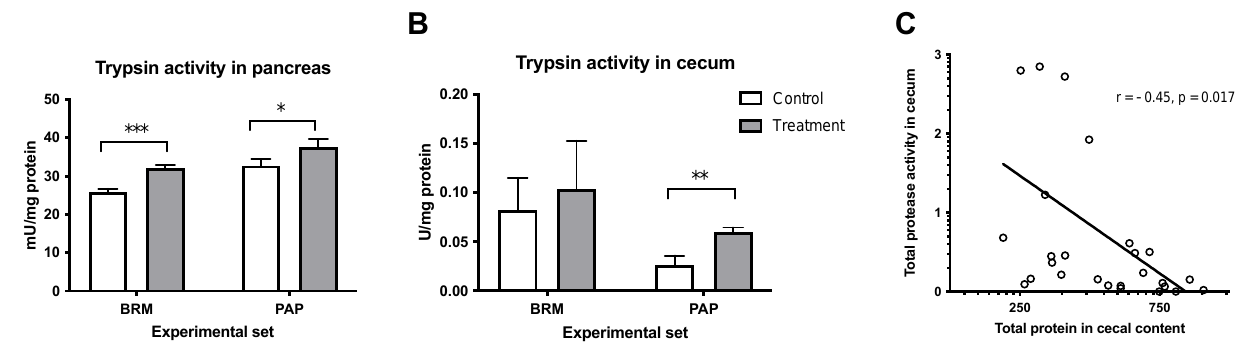
Figure 4. Effect of bromelain and papain on the activity of trypsin in the pancreas ( A ) and cecum ( B ). A t-test was used, and the Pearson correlation test was used to determine the total protease activity to total protein in the cecum ( C ). Significant differences denoted by * p < 0.05, ** p < 0.01 *** p < 0.001. Values are represented as mean ± SEM for n = 6 – 7 per group.